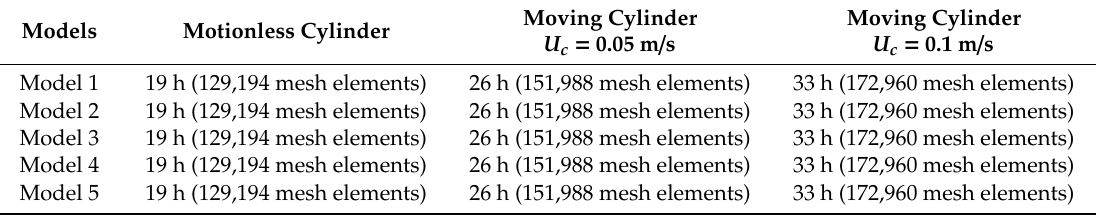
Table 2. The computational time and numbers of mesh elements.